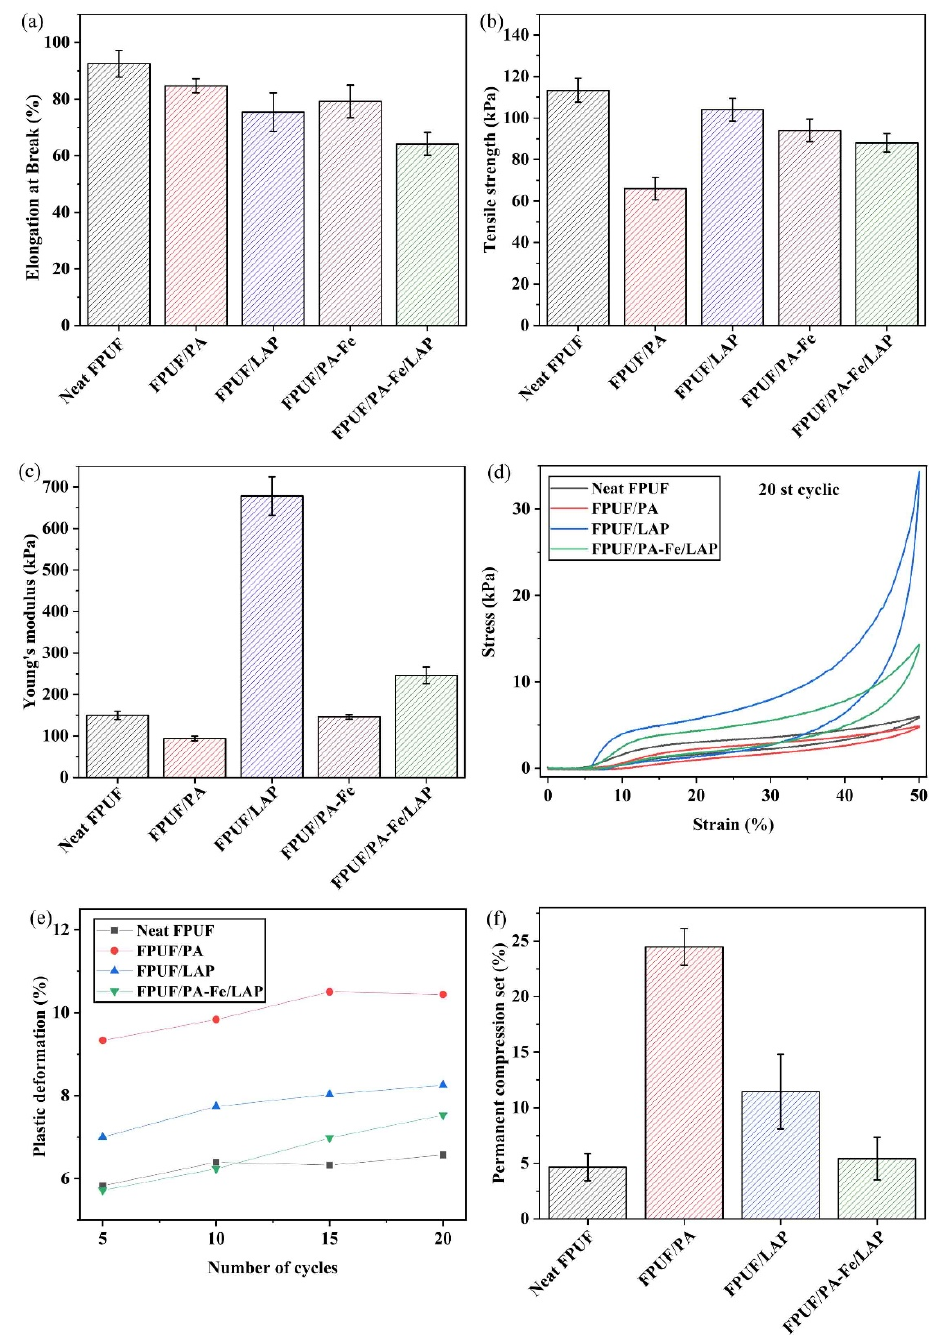
Figure 10. Tensile properties ( a – c ), stress-strain ( d , e ), and permanent deformation ( f ) of neat FPUF, FPUF/PA, FPUF/LAP, and FPUF/PA-Fe/LAP.